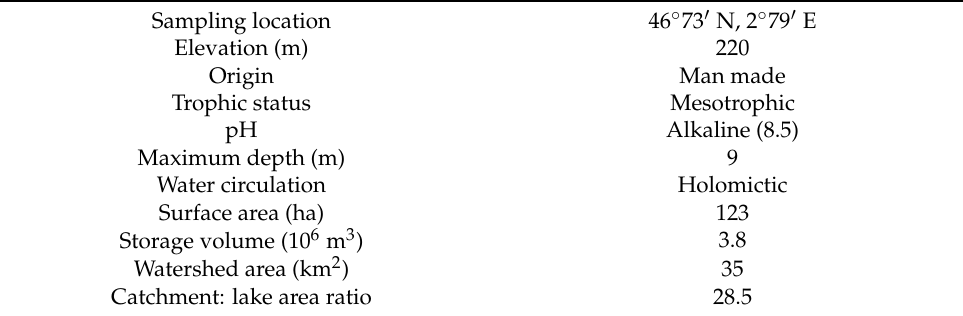
Table 1. Hydrological and morphological characteristic of Lake Goule